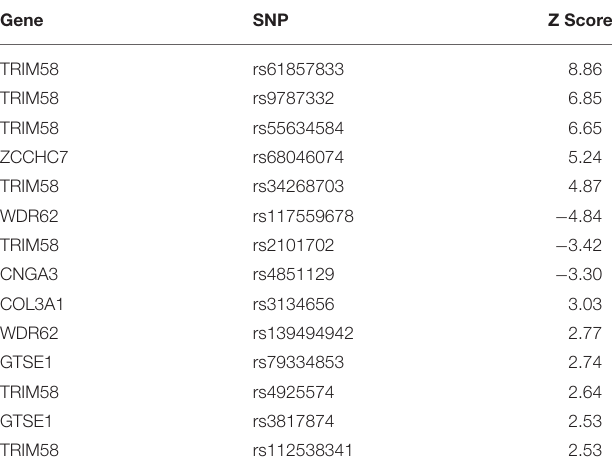
TABLE 6 | Dominant SNPs (Z-Threshold = 2.5) associated with gray matter density on SNP component 12 by Parallel